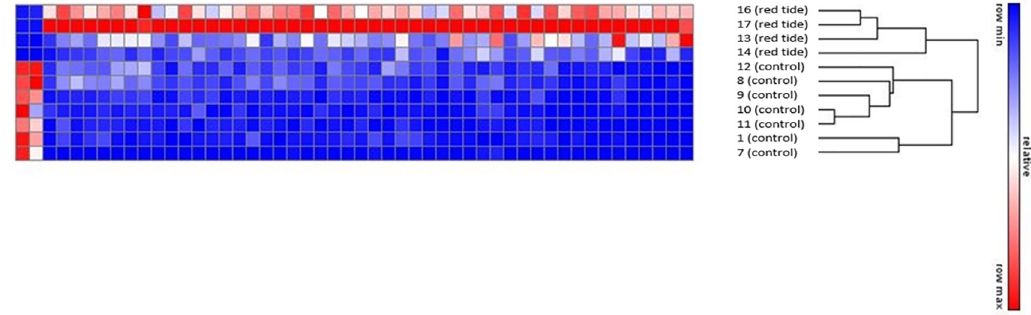
Fig 1. Heat map and dendrogram of individual gene expression data obtained by RNA-Seq for manatees exposed to red tide and an experimental control group. Hierarchical clustering was performed on genes that were differentially expressed (p-value < 0.05 and FDR < 0.2) and self-grouped based on the clustering pattern as shown by the dendrogram. Red indicates up-regulation and blue indicates down-regulation of gene expression. The intensity of the color is proportional to the degree of up or down- regulation. The sample numbers and red tide or control classification are indicated to the right. Samples 8 and 14 are female; other samples are male.